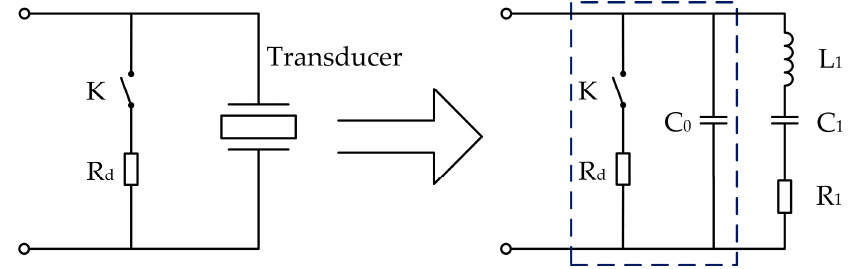
Figure 6. Model of the residual vibration reduction and its equivalent circuit.